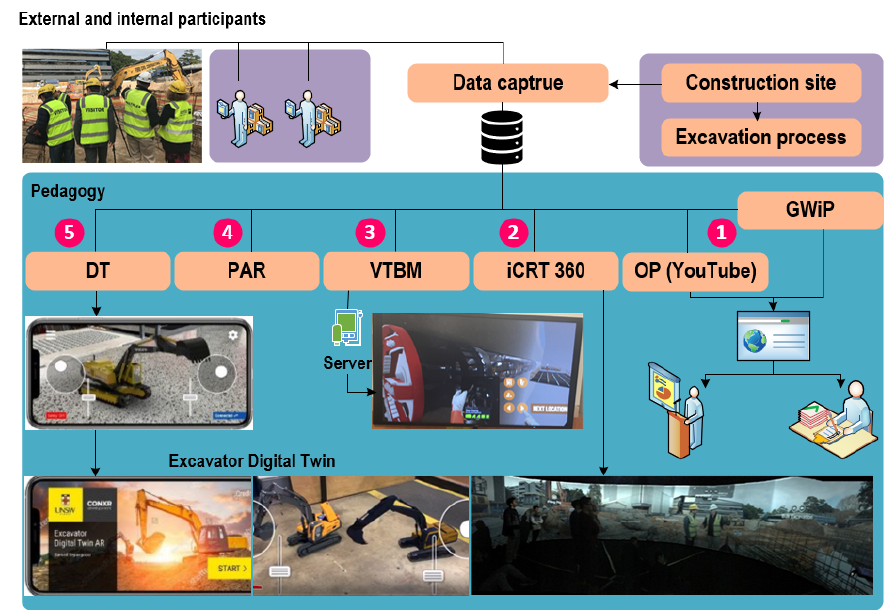
Figure 2. The flowchart of developed online modules, including screenshots of the applications, including Excavator Digital Twin.